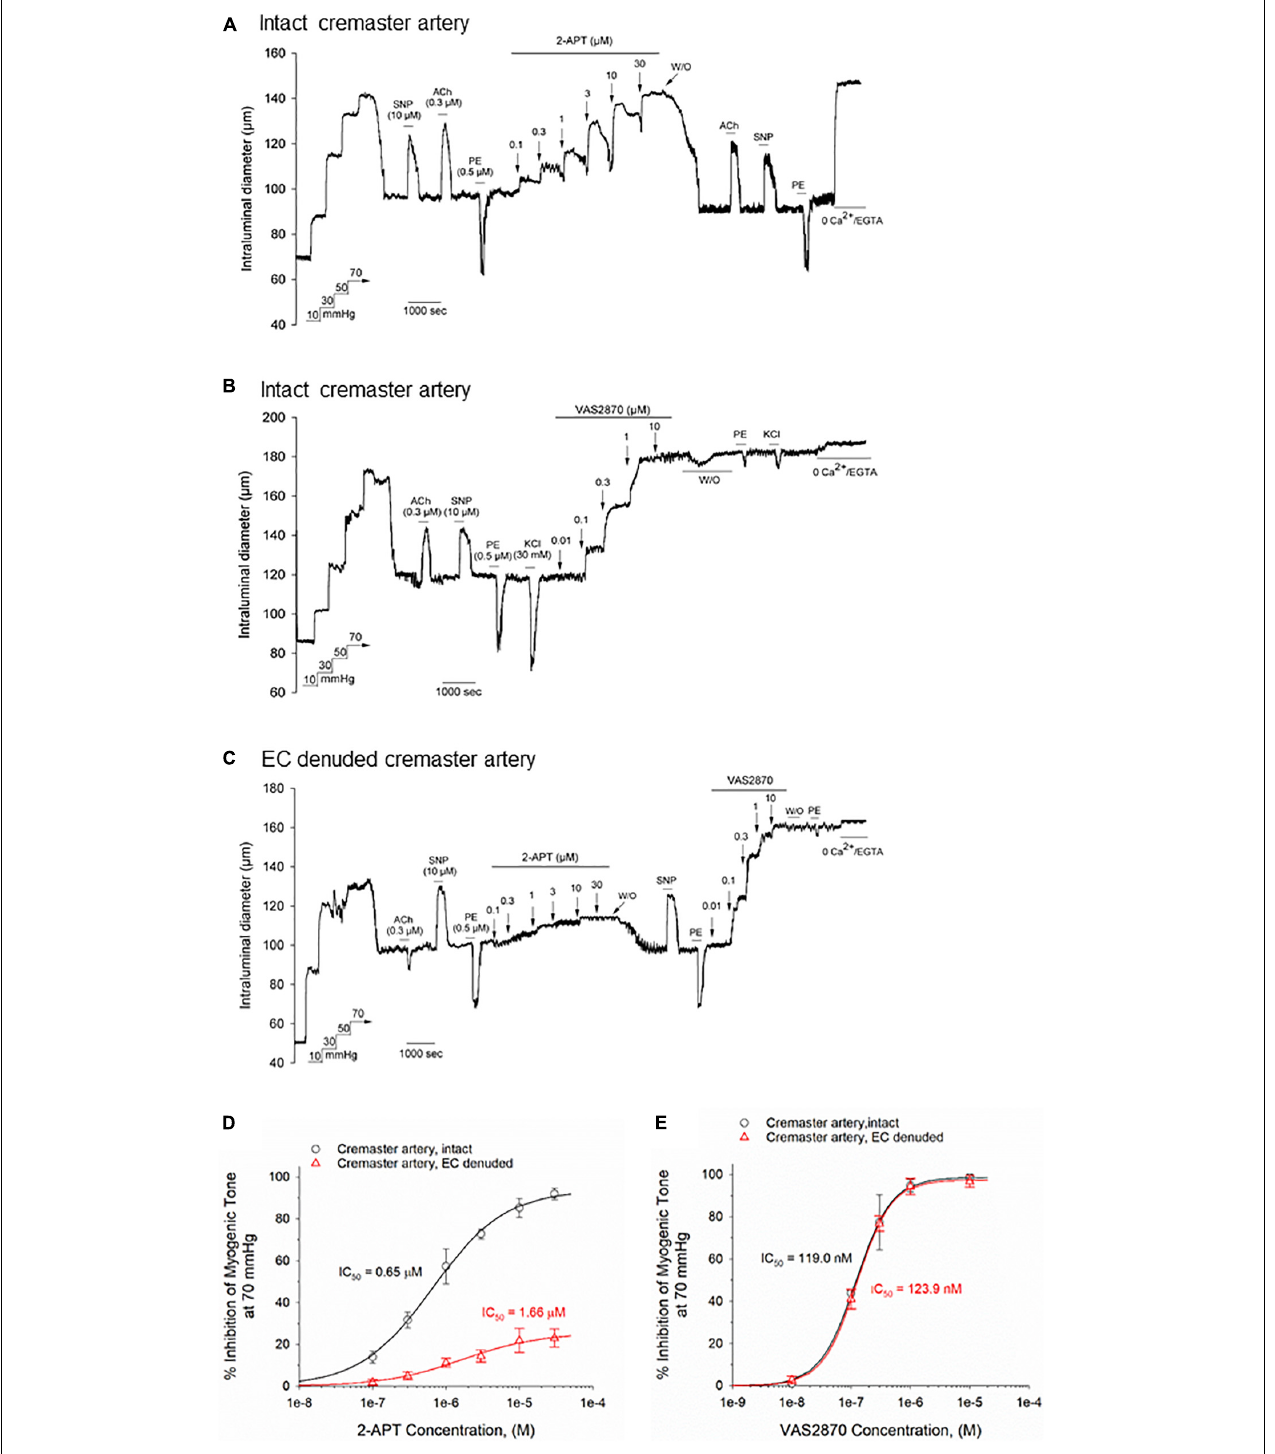
FIGURE 2 | The selective NOX inhibitors 2-acetylphenothiazine (2-APT) and VAS2870 produce endothelium-dependent and -independent inhibition of basal myogenic tone in Sprague–Dawley rat cremaster arteries. Panel (A) shows a representative tracing of the reversible vasoactive responses to increasing concentrations of 2-APT (0.1–30 µ M) perfused through the bath in a sequential manner, followed by washout. Stimulation of the artery with acetylcholine (ACh, 0.3 µ M), sodium nitroprusside (SNP, 10 µ M) and phenylephrine (PE, 0.5 µ M) demonstrate responsiveness to endothelium-dependent and –independent vasoactive agents prior to and following 2-APT treatment. At the end of the experimental protocol, the artery was superfused with a physiological saline solution containing 0 added CaCl 2 + 2 mM EGTA to evoke the maximal arterial diameter. The representative tracing in panel (B) displays a comparable experimental procedure as shown